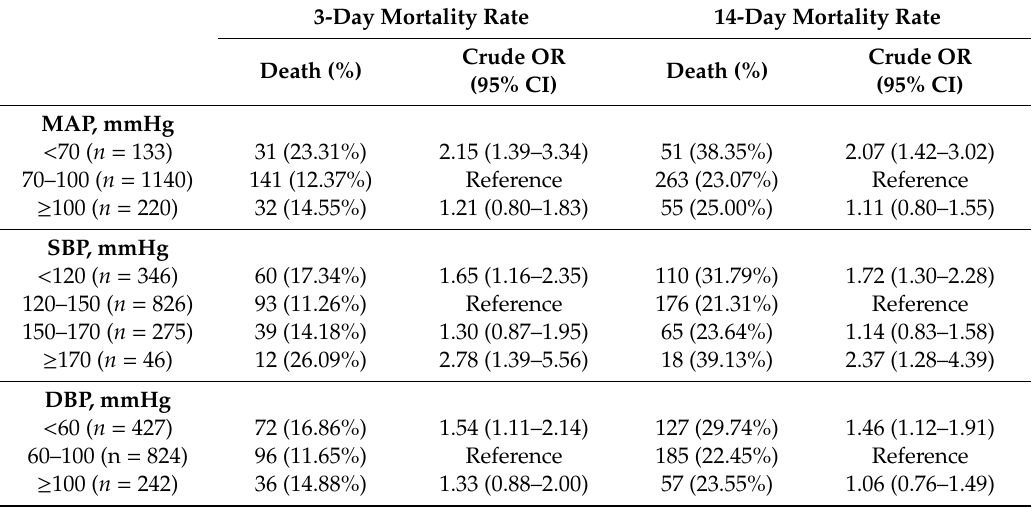
Table 2. The 3-day and 14-day mortality rate in ICU patients with non-traumatic hemorrhage represented by their mean arterial pressure (MAP), systolic blood pressure (SBP), and diastolic blood pressure (DBP)